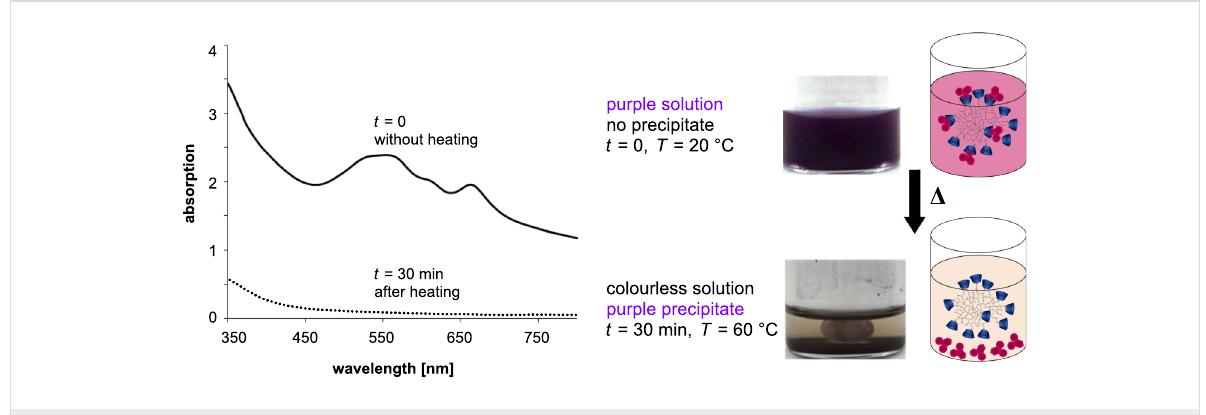
Figure 2: UV–vis spectra of complex 5 in solution before heating (solid line) and after 30 min of heating at 60 °C (dotted line), and corresponding photos and schematic illustrations of the solution.